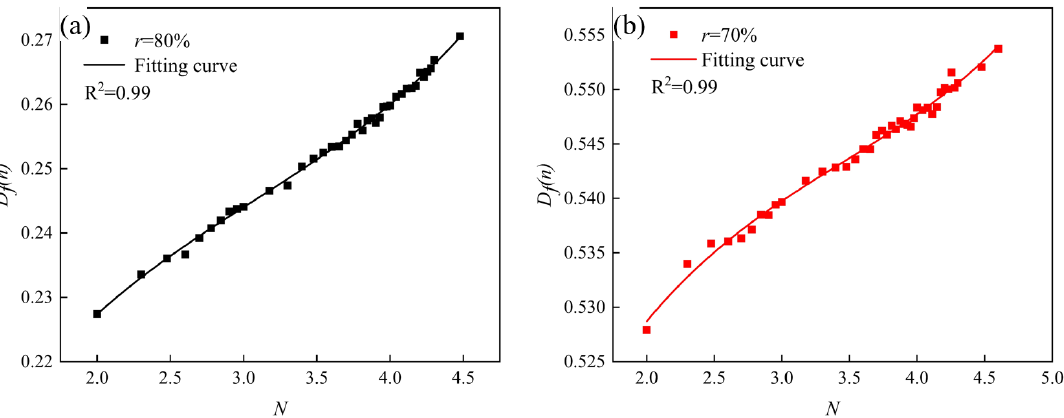
Figure 13. Fatigue damage fitting curves at the stable stage. (Specimens made by the powder metallurgy method, N = lg n ). ( a ) r = 80%, ( b ) r = 70%.